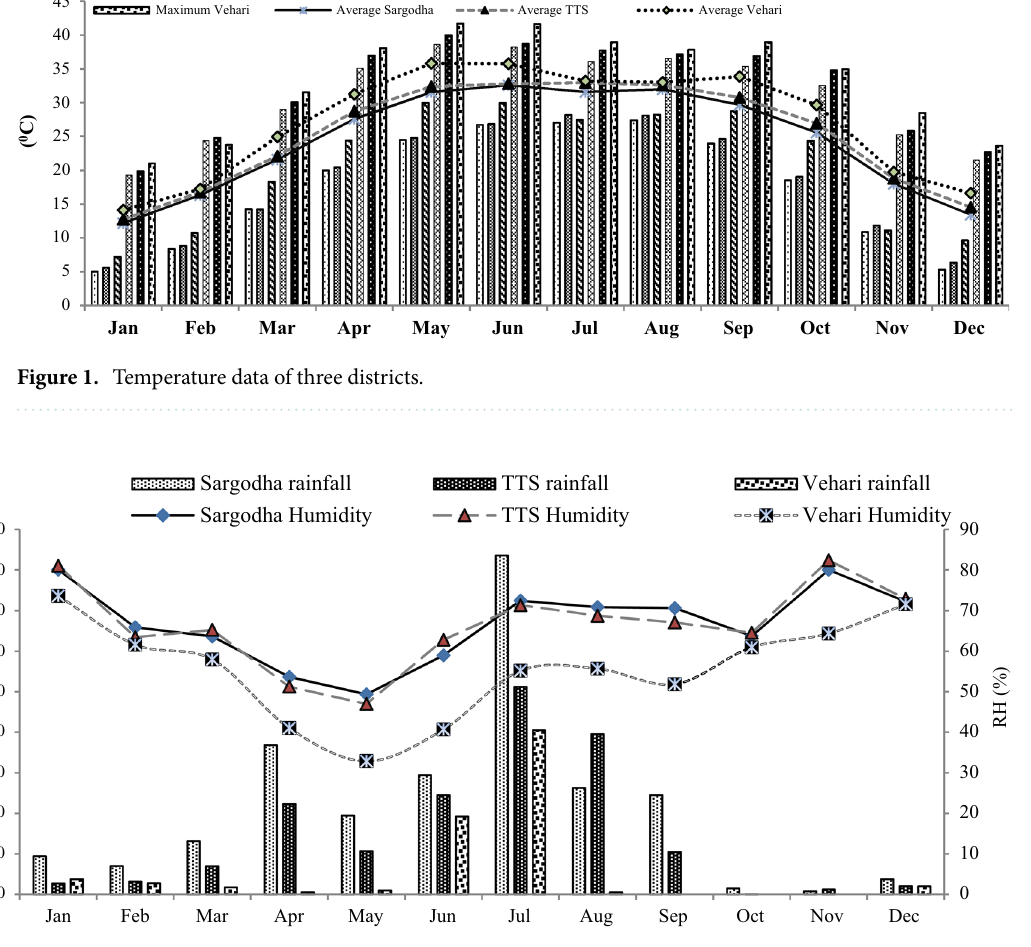
Figure 2. Weather data (rainfall and average relative humidity) of three